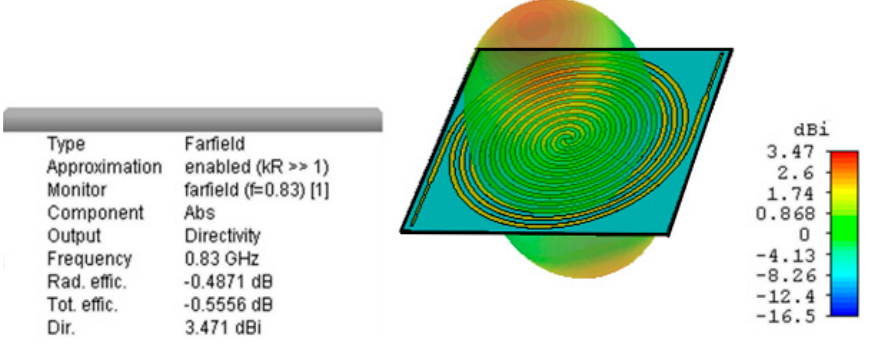
Figure 6. 3D farfield radiation pattern at 830 MHz.